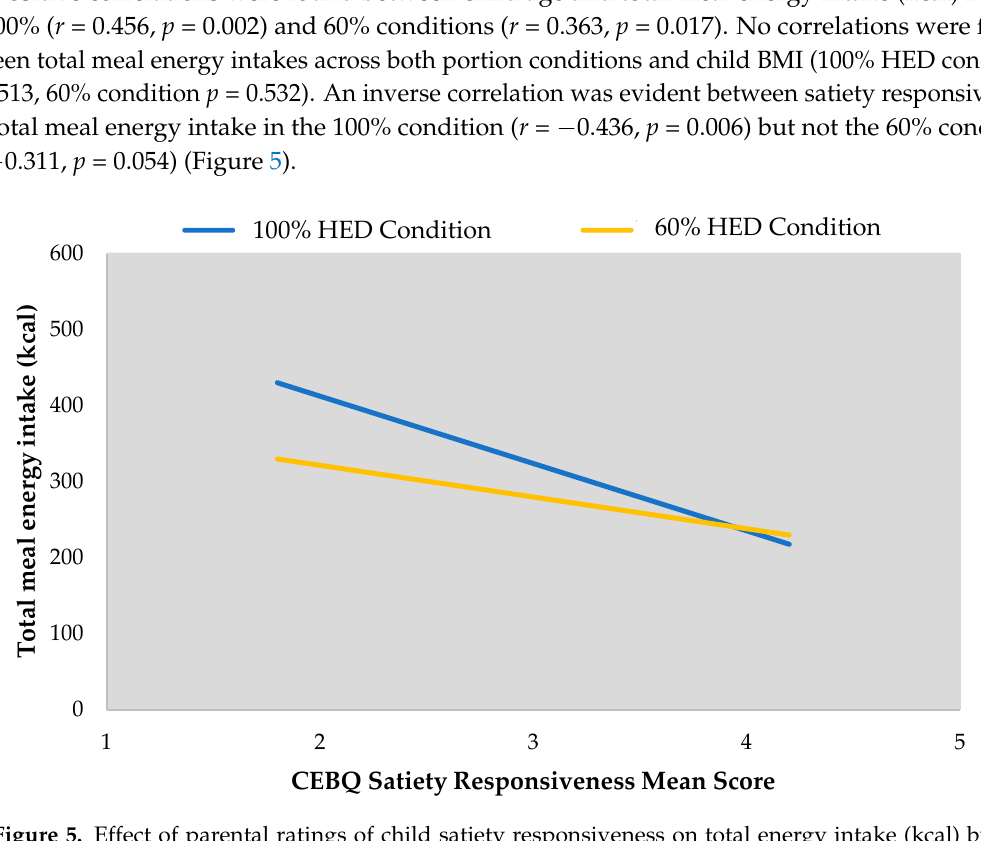
Figure 5. Effect of parental ratings of child satiety responsiveness on total energy intake (kcal) by portion condition.